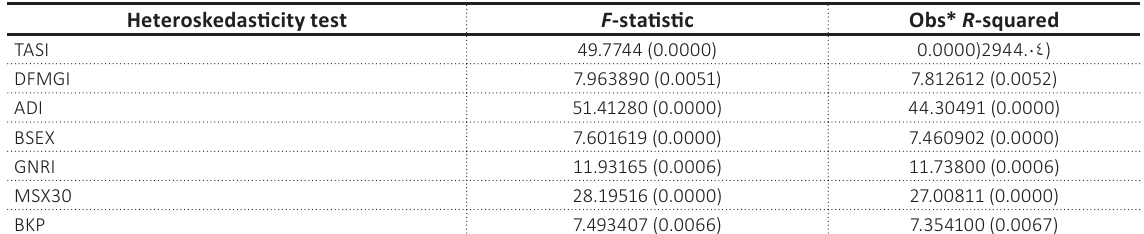
Table 5. Heteroskedasticity test: ARCH